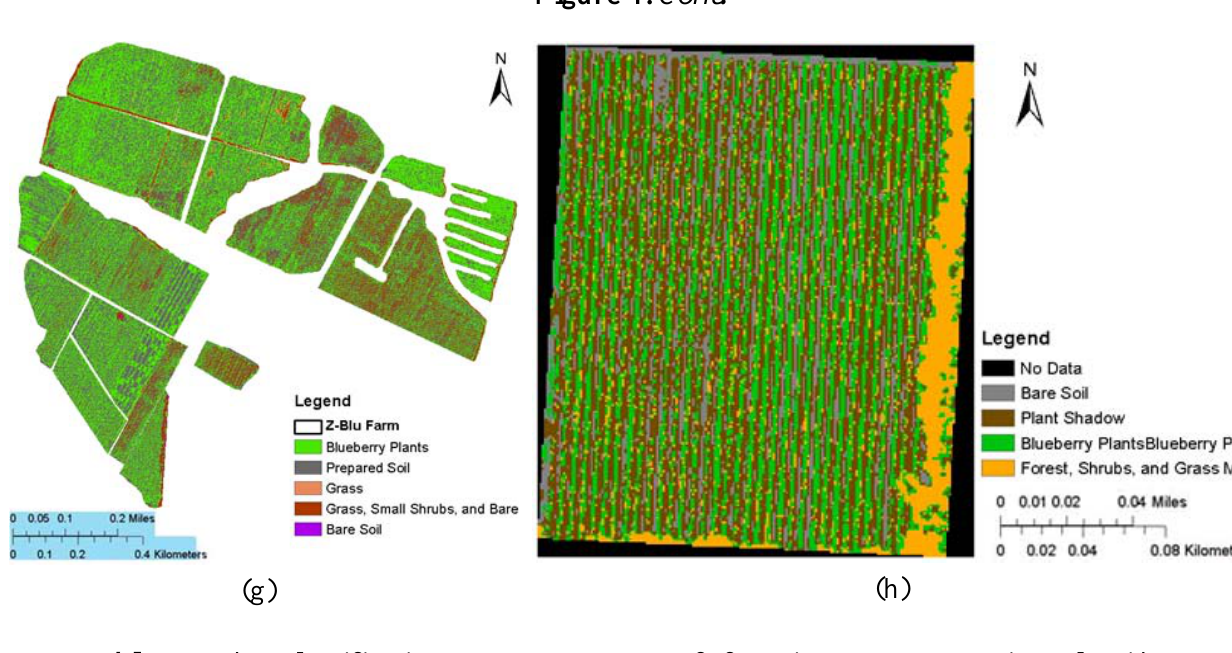
Table 1. The classification accuracy report of four image segmentation algorithm applications on Z-Blu Farm 2009 NAIP imageries.